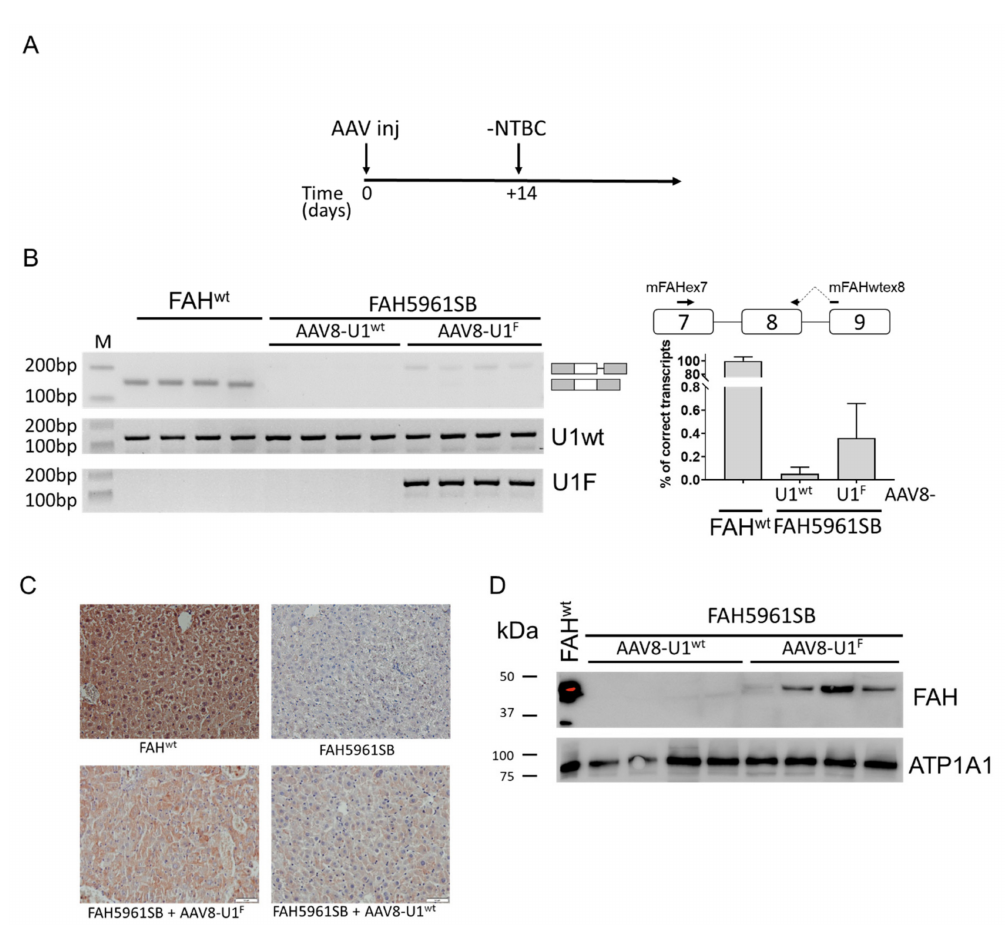
Figure 2. The compensatory U1 F partially rescues FAH expression in vivo . ( A ) Schematic representation of the protocol designed to perform the experiments in mice and exploiting the AAV8-mediated delivery of the U1snRNAs. Mice, kept on NTBC in their drinking water, were injected with 1*10 13 vg / kg of body weight of AAV8-U1 F or AAV8-U1 wt and transferred to normal drinking water without NTBC (-NTBC) 14 days later ( + 14). ( B ) FAH splicing pattern profiles in mouse livers, together with the schematic representation of transcripts, reported on the right side. The quantification of correctly spliced FAH transcript by qPCR is indicated on the right, with the schematic organization of FAH gene region and the exploited primers (on top). Results are reported as percentage of correctly spliced transcripts (mean ± SD). ( C ) Immunohistochemical analysis of FAH expression in liver sections of wild type (FAH wt ) and FAH5961SB mice, either untreated or treated with AAV8-U1 wt or AAV8-U1 F . Representative examples of liver sections stained with a specific anti-FAH antibody (brown). Images are taken at 20 × magnification. Scale bar, 50 µ m. ( D ) Western blotting analysis through a specific anti-FAH antibody in liver homogenates of wild type (FAH wt ) and FAH5961SB mice treated with AAV8-U1 wt or AAV8-U1 F . The mouse ATPase Na + / K + Transporting Subunit Alpha 1 ( ATP1A1 ) was exploited as load control.